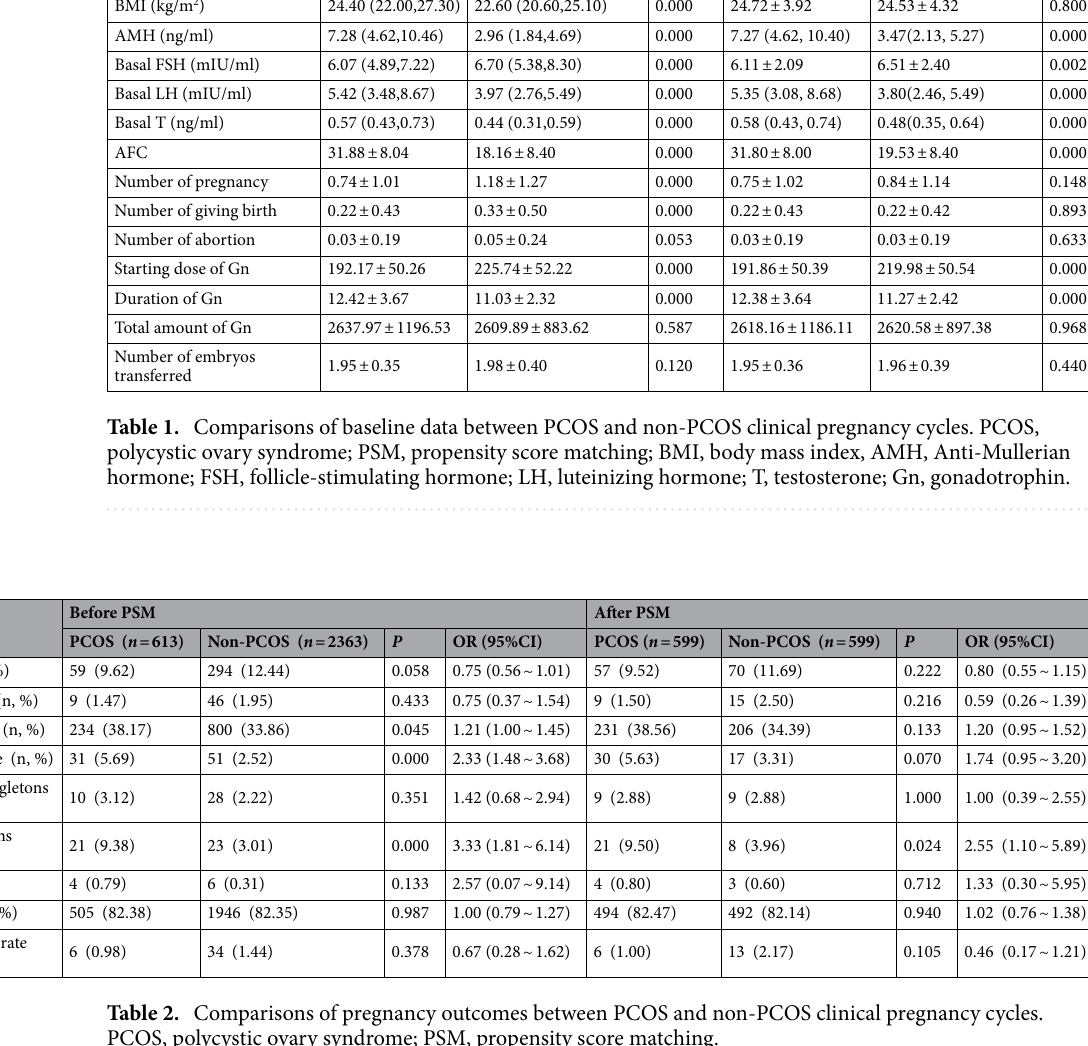
Table 2. Comparisons of pregnancy outcomes between PCOS and non-PCOS clinical pregnancy cycles. PCOS, polycystic ovary syndrome; PSM, propensity score matching.